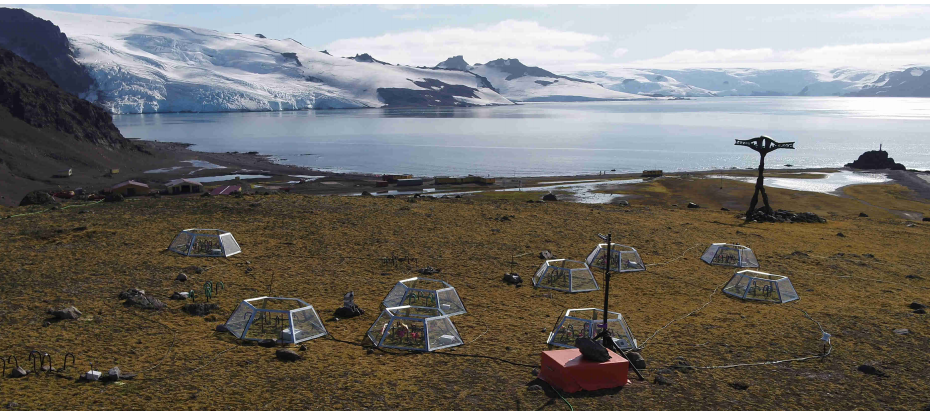
Figure 3. The aerial view of the measurement spot. In the foreground, the sensor actuator network is presented. In the background, H. Arctowski Polish Antarctic Station and the Admiralty Bay. A schematic, top view of the spot is presented in Figure 5. A totem on the right is a W. Puchalski grave, which is listed as an HSM-51 (Historic Site or Monument) by the Antarctic Treaty